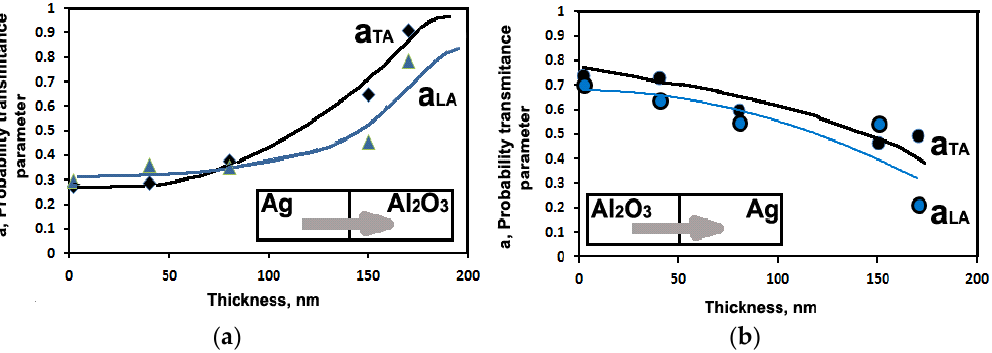
Figure 9. Probability of phonon energy transmittance across interfaces in Ag/Al 2 O 3 layer nanocomposite from Ag to alumina nanolayer ( a ) and from alumina to silver ( b ) depending on individual layer thickness and direction of propagation across phase boundary.